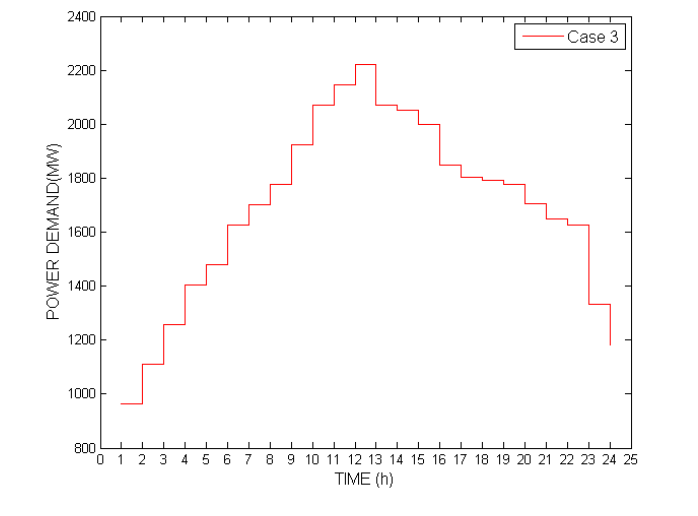
Figure 3. Initial power demand for Case 3.